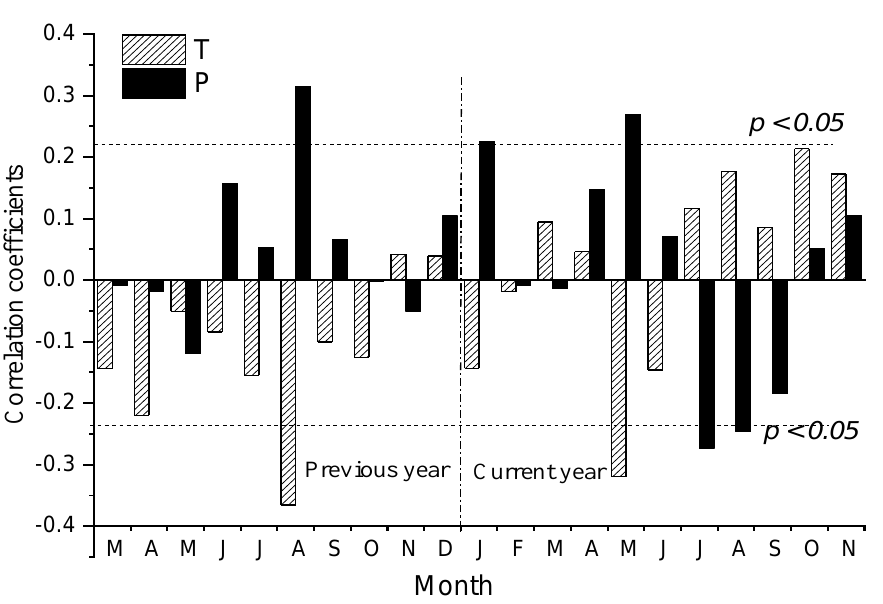
Figure 5. Correlations between PC1 and regional T and P from 1961 to 2016.